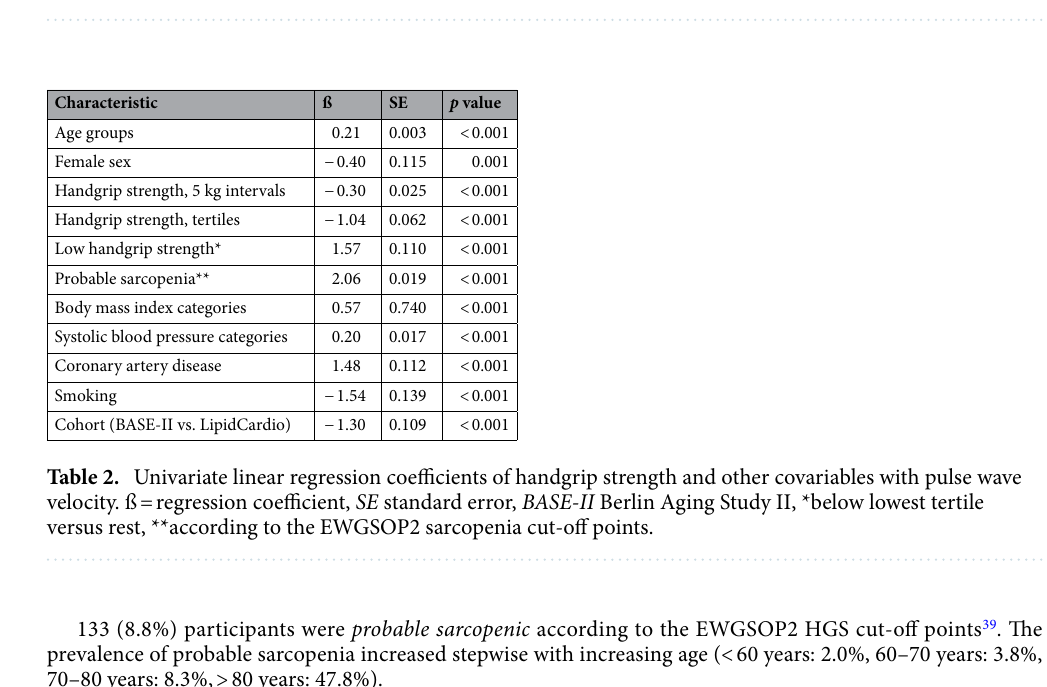
Table 1. Participant characteristics by sex and tertiles of handgrip strength. Numbers are mean ± SD or number (%); HGS handgrip strength, PWV pulse wave velocity, CAD coronary artery disease, BMI body mass index, SBP systolic blood pressure.